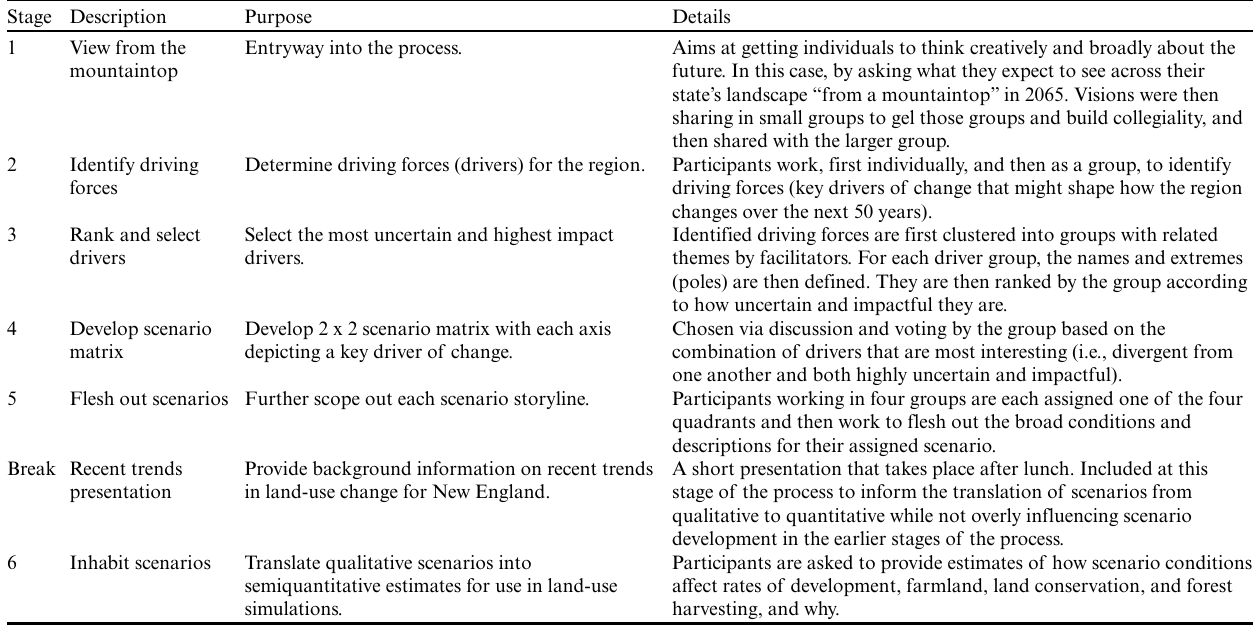
Table 4 . Six stage scenario development process employed during the stakeholder